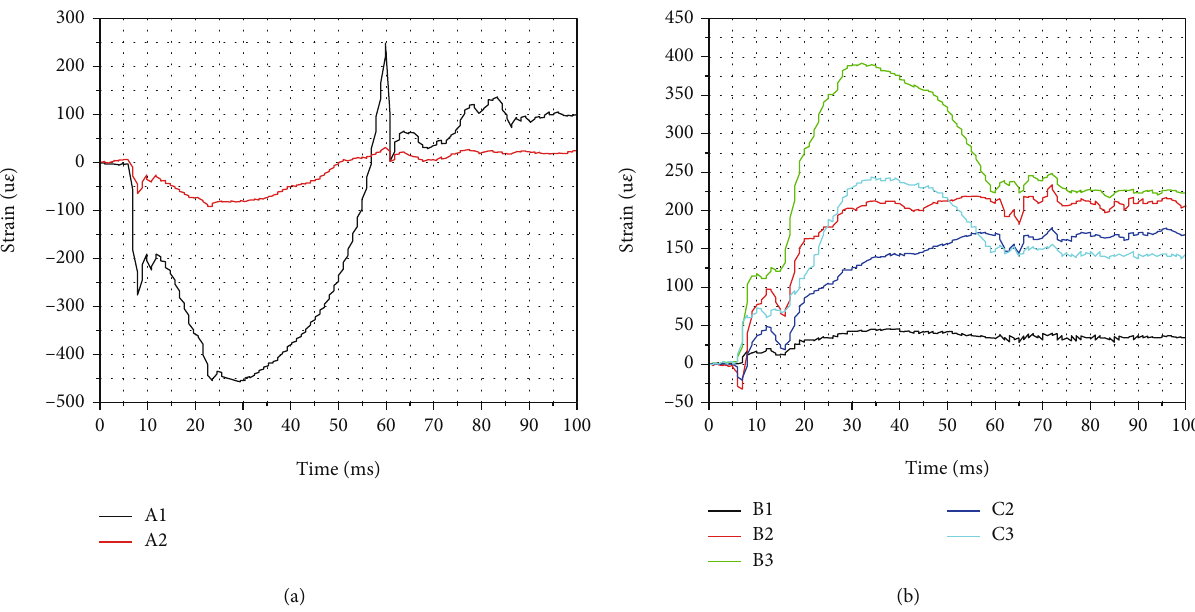
Figure 15: Monitored strains in the second shock: (a) vertical grating string; (b) transverse grating